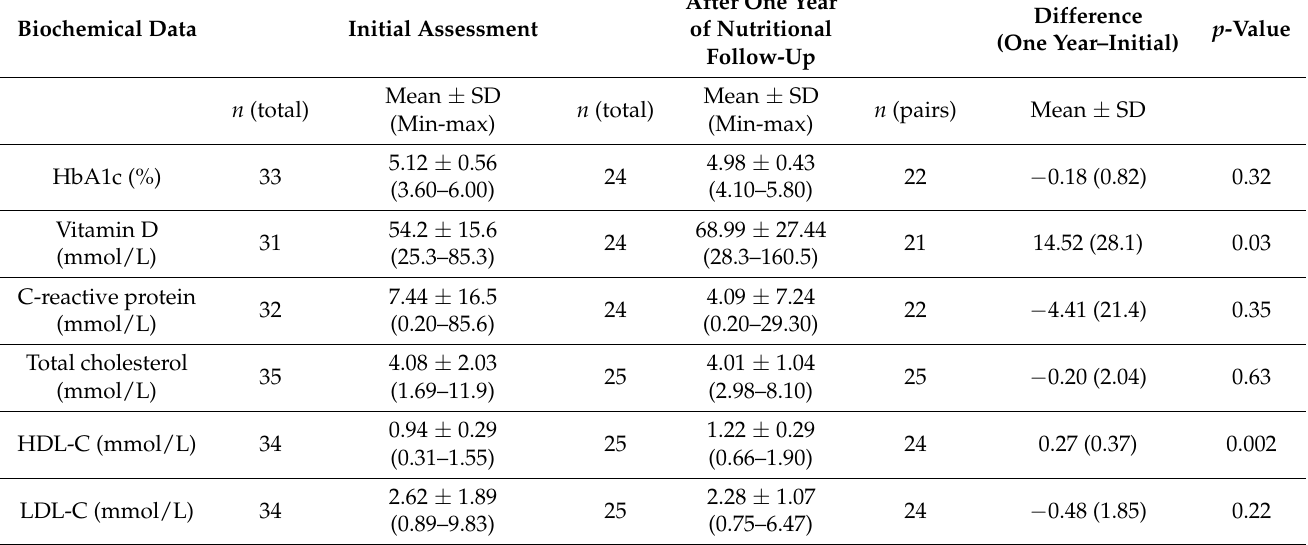
Table 4. Biochemical data of the participants at the initial assessment and after one year of nutritional